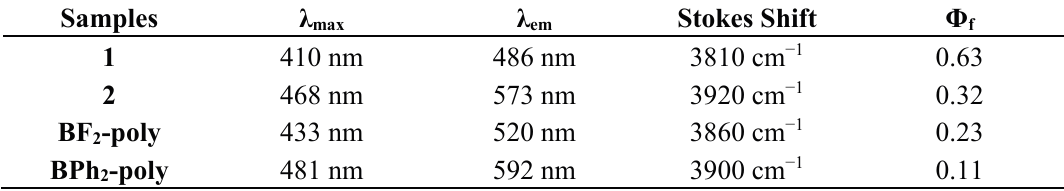
Figure 5. UV–vis spectra of BF state ( b ), respectively. Table 2. Absorption and fluorescence data for relating compounds in CH 2 Cl 2